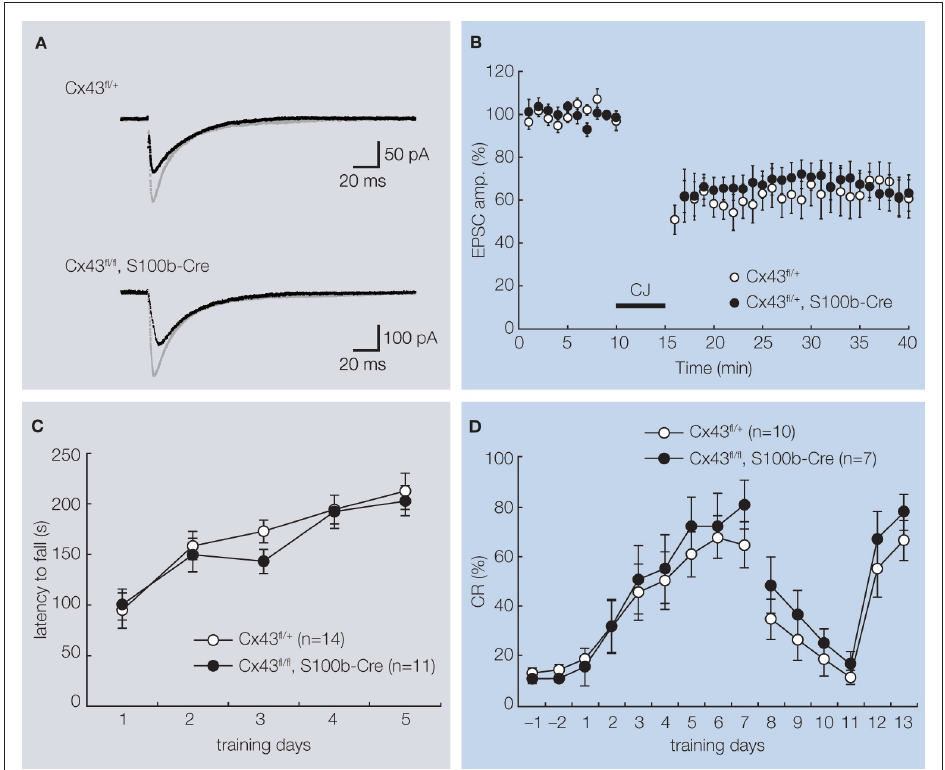
Figure 4 | Basal PF-PC EPSC, LTD induction, and behavioral analysis of control ( Cx43 fl/ + ) and Cx43 fl/fl : S100b-Cre mice. (A) A representative example of PF-EPSC before (gray) and after (black) conjunctive stimulation in Cx43 fl/ + and Cx43 fl/fl : S100b-Cre mice. Six records are averaged. (B) PF-EPSC amplitude was plotted against time before and after conjunctive stimulation averaged for eight cells from 8 Cx43 fl/ + mice or for nine cells from 8 Cx43 fl/fl : S100b-Cre mice. Each point represents the average of three successive responses acquired for 1 min at 0.05 Hz. Bar indicates the period of conjunctive stimulation (CJ). (C) Accelerating rotarod test. The mean ( ± SEM) time an animal remained on an accelerating rod (6–40 rpm) during training with one trial per day for five consecutive days ( n = 14 for Cx43 fl/ + , and n = 11 for Cx43 fl/ fl : S100b-Cre ). (D) Delay eyeblink conditioning. The mean ( ± SEM) conditioned response (CR) percentage of Cx43 fl/ + ( n = 10) and Cx43 fl/fl : S100b-Cre ( n = 7) during acquisition (days 1–7), extinction (days 8–11), and relearning (days 12–13) sessions. Modified and reproduced from Tanaka et al. (2008). Front. Behav. Neurosci. 2,